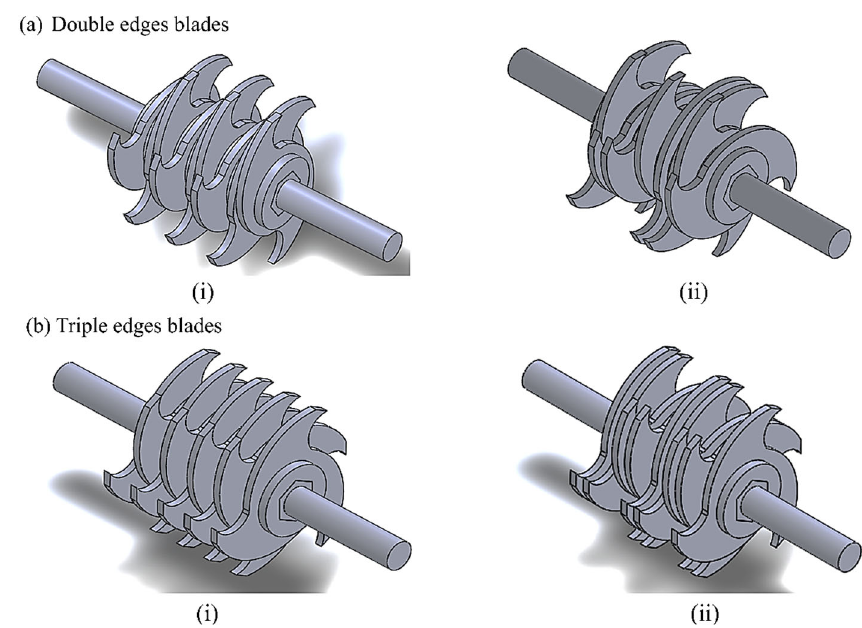
Figure 2. ( a ) Double ‐ edge, and ( b ) triple ‐ edge blades in ( i ) spiral, and ( ii ) V ‐ orientation.